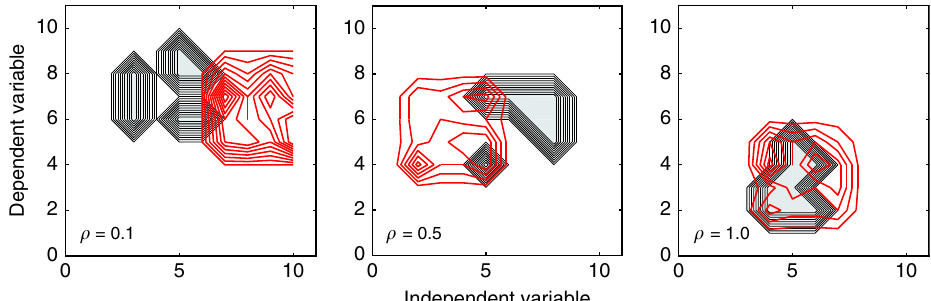
Fig. 6 The role of theory in the model. Each panel shows the same landscape of ground truth as in Fig. 3. In each panel, the gray contours illustrate the location of true effects (randomly chosen for each replication) and the red lines outline the space of experiments actually conducted as determined by the theory. Unlike in discovery-oriented research, true effects and experiments cluster together. The quality of the theory (determined by parameter ρ ) is re fl ected in the overlap between the true state of the world (gray cluster) and the experiments (red cluster). The leftmost panel shows a poor theory ( ρ ¼ 0 : 1), the center panel a modestly powerful theory ( ρ ¼ 0 : 5), and the rightmost panel a perfect theory ( ρ ¼ 1 : 0). Each panel represents a single arbitrarily chosen